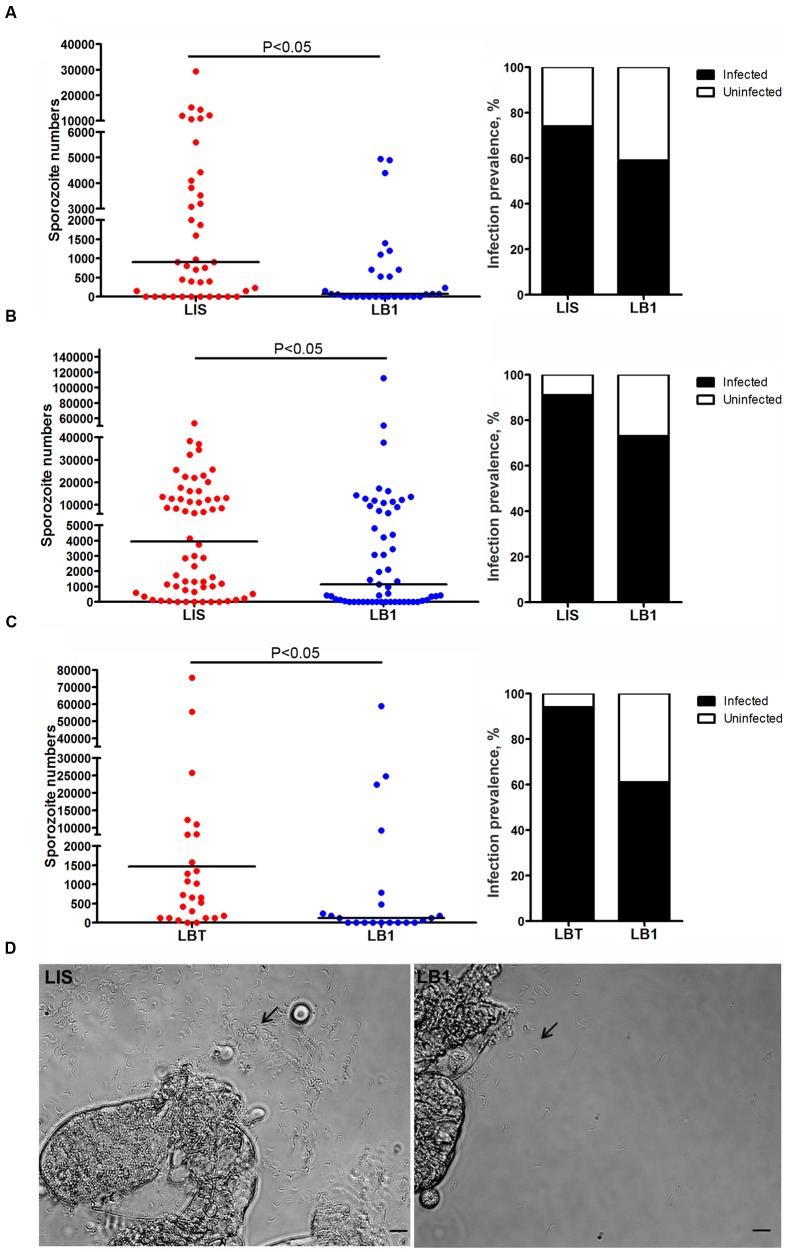
Wolbachia wAlbB-mediated reduction in P. berghei sporozoite loads in LB1 salivary glands. P. berghei sporozoite loads in salivary glands of A. stephensi LB1 strain and its infection prevalence are compared to those of LIS (A,B) and LBT strains (C). Points represent the number of parasites from an individual mosquito and horizontal lines indicate the median number of parasites per tissue. P-value is indicated based on Mann–Whitney test. (D) One representative salivary glands from LIS and LB1 strain is shown, with an arrow indicating the sporozoite.